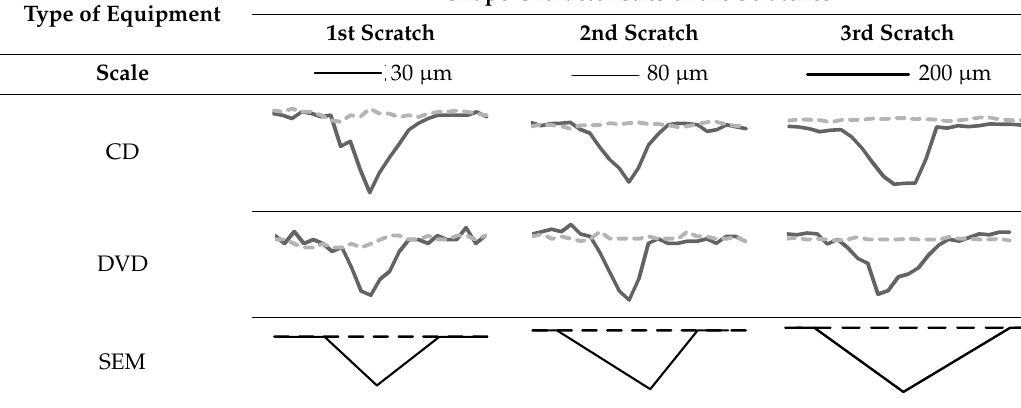
Table 3. Shape characteristics of 3 scratches measured from the CD pick-up head, DVD pick-up head, and SEM.